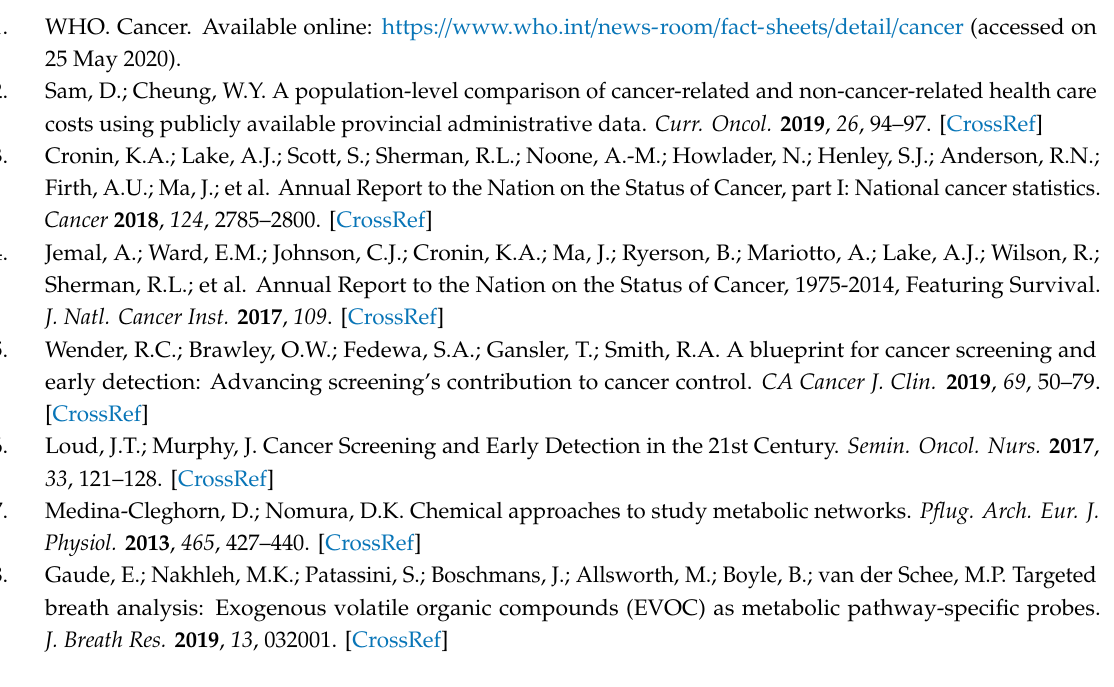
Supplementary Table S1: Characteristics of study participants. Supplementary Table S2: Detection frequencies, median (IQR), minimum, and maximum concentrations (ng / L air) in exhaled breath of study’s participants. Supplementary Table S3: Summary of correct classification, based on naïve Bayes, logistic regression, and random forest machine learning methods. Supplementary Table S4: Range of calibration, detection limits (LOD), quantification limits (LOQ), and the linearity of the detector response (R2) and coe ffi cients of variation for 5 consecutive calibration curves. Supplementary Figures S1–S17: Median breath concentrations of lung cancer patients and healthy controls in comparison with the corresponding ambient air